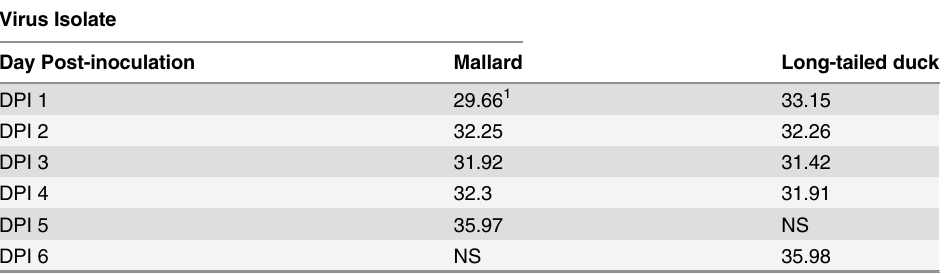
Table 9. RT-PCR analysis of environmental samples * from common eiders experimentally inoculated with Influenza A H3N8